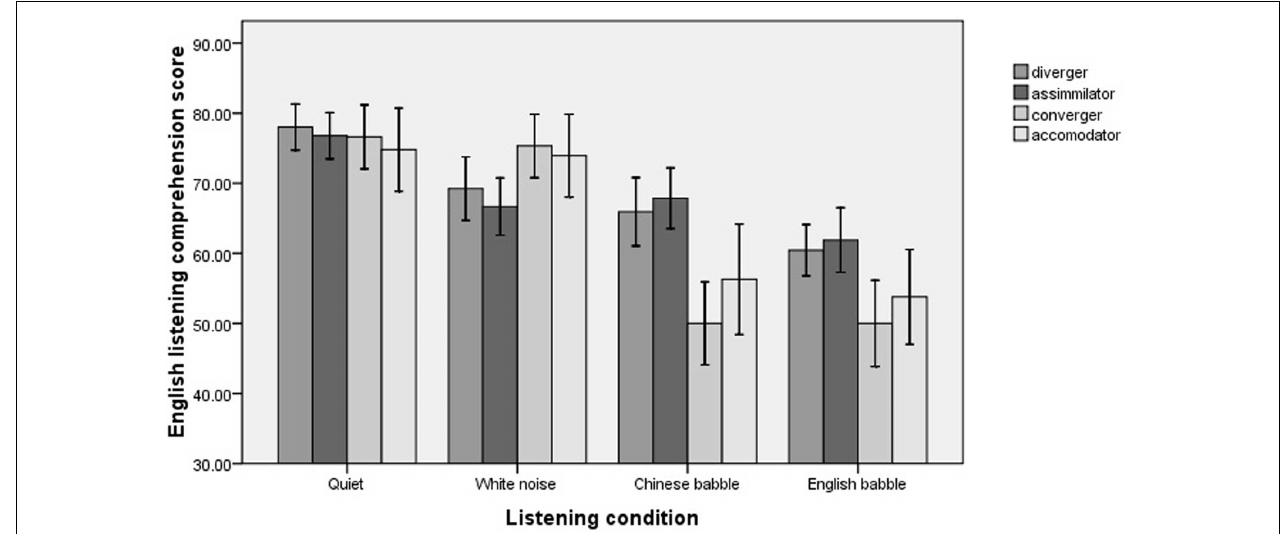
FIGURE 1 | Participants’ English listening comprehension in different listening